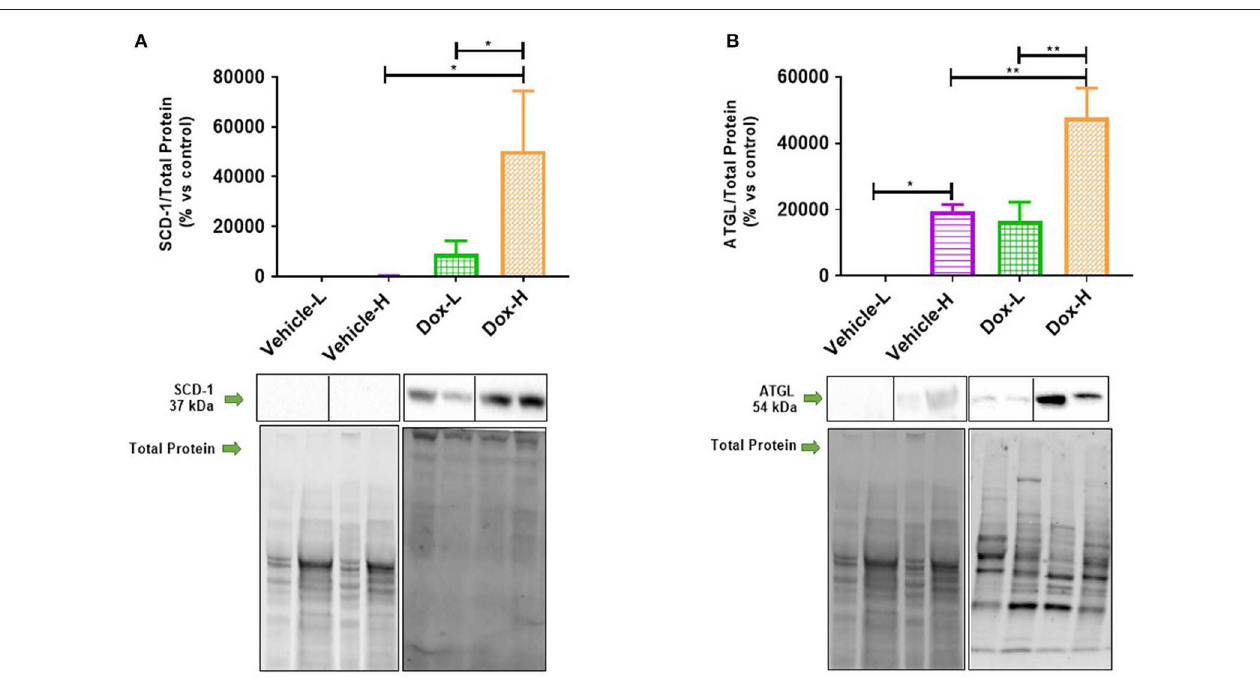
FIGURE 8 | Western blot analysis of lipid metabolism protein expression in tumor tissue of vehicle control and doxorubicin treatment groups on LFD and HFD; (A) SCD-1 ( n = 5) and (B) ATGL ( n = 4). Results are presented as mean ± SEM. Two-way ANOVA with Fisher’s LSD post hoc correction was applied and p < 0.05 was considered as statistically significant. * p < 0.05, ** p <